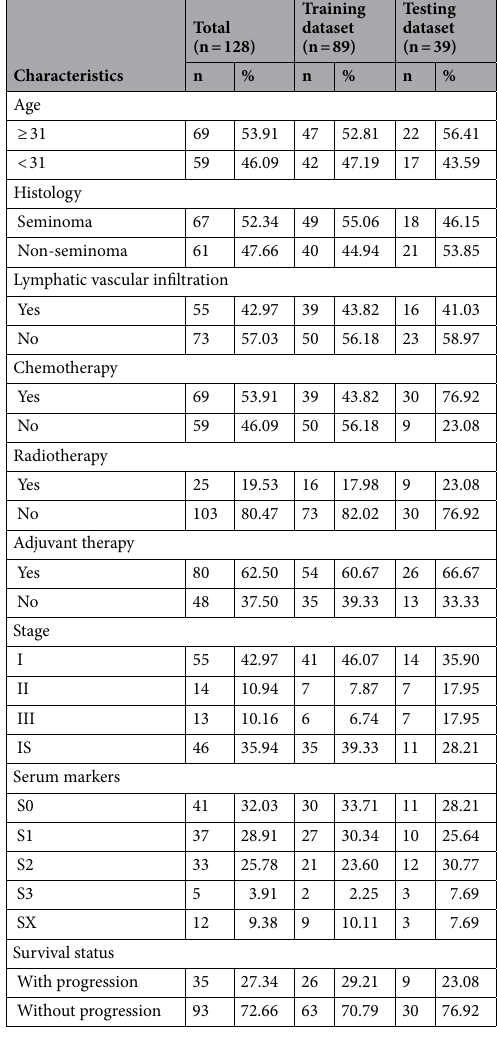
Table 1. Clinical characteristics of included